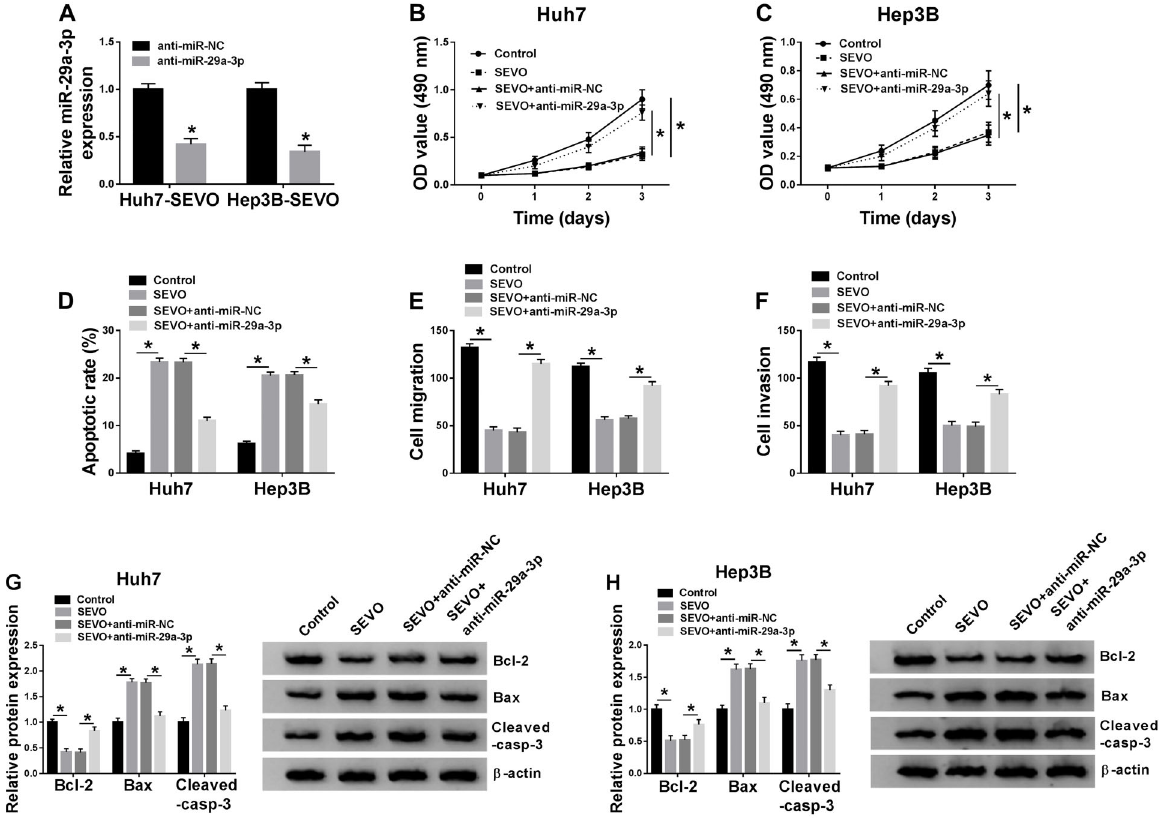
Figure 4. miR-29a-3p depletion blocked the effects of sevo fl urane (SEVO) on hepatocellular carcinoma (HCC) progression. The Huh7 and Hep3B cells were transfected with anti-miR-29a-3p or anti-miR-NC (negative control) and then stimulated with 4% SEVO for 48 h. A , miR-29a-3p expression was examined by qRT-PCR (n=3). B and C , MTT assay was employed to assess cell proliferation ability (n=3). D , Flow cytometry was used to determine cell apoptosis rate (n=3). E and F, Transwell assay was employed to assess cell migration and invasion (n=3). G and H , The levels of cell apoptosis-related proteins were detected by western blot assay (n=3). Data are reported as means ± SD. *P o 0.05 (Student ’ s t -test or